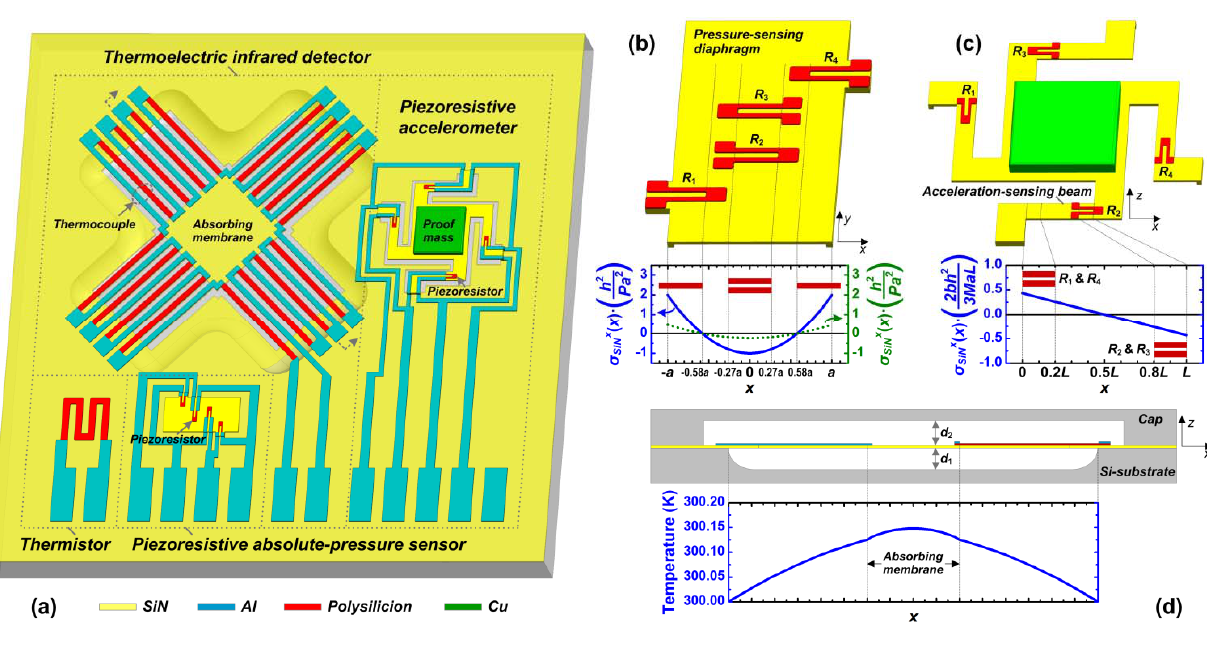
Figure 2. ( a ) Schematic of the prototype “pressure + acceleration + temperature + infrared” (PATIR) composite sensor design (cap not shown here). ( b ) The absolute-pressure sensor with the stress-distribution in pressure-sensing diaphragm. ( c ) The accelerometer with stress-distribution analysis along the beam. ( d ) The infrared detector (cross-section view) with simulated temperature